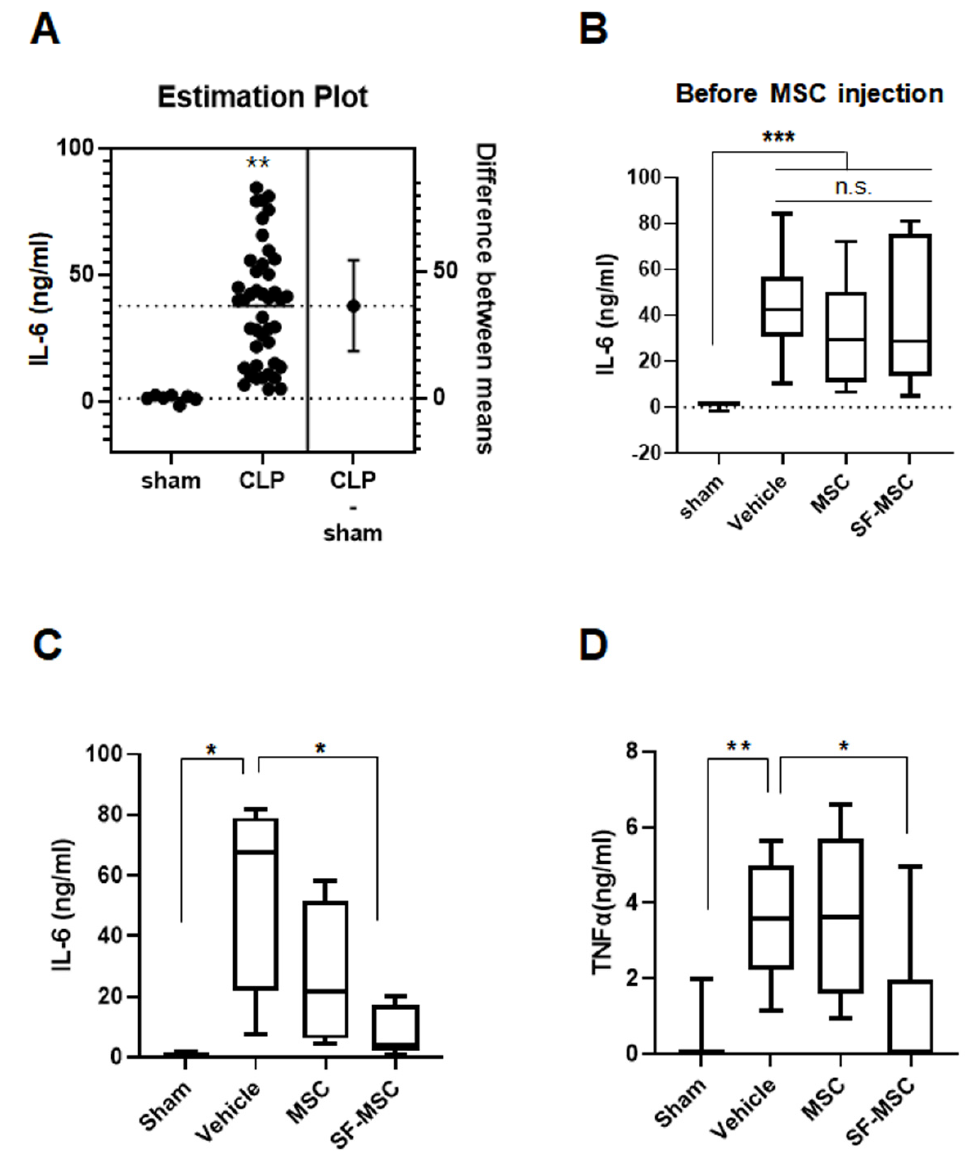
Figure 3. Primed MSCs on the SF nanofibers suppress the level of inflammatory cytokines in septic mice. ( A ) Plasma IL-6 levels were elevated in the CLP mice ( n = 7 animals in the sham group vs. n = 43 animals in the CLP group, unpaired t -test, p = 0.0006). ( B ) IL-6 levels did not differ between the groups before the administration of MSCs (1.28 ng/mL in sham, 43.72 ng/mL in CLP group before injecting vehicle, 32.65 ng/mL in CLP group before injecting primed MSCs on the control surface, 37.77 ng/mL in CLP group before injecting primed MSCs on the SF nanofibers, one-way ANOVA, *** p < 0.001). ( C ) IL-6 levels were significantly reduced in the septic mouse group injected with primed MSCs on the SF nanofibers at 24 h (0.557 ng/mL in sham, 34.50 ng/mL in CLP group, 16.14 ng/mL in CLP with primed MSCs on the control surface, 6.458 ng/mL in CLP with primed MSCs on the SF nanofibers, one-way ANOVA, and * p < 0.05). ( D ) TNF- α levels were highly enhanced in the CLP mice, while effectively attenuated by primed MSCs on the SF nanofibers (0.2843 ng/mL in sham, 3.501 ng/mL in CLP group, 3.5412 ng/mL in the CLP with primed MSCs on the control surface, 1.006 ng/mL in the CLP with primed MSCs on the SF nanofibers, one-way ANOVA, * p < 0.05, and ** p < 0.01). Abbreviation: MSC, primed MSCs on the control surface; SF_MSC, primed MSCs on the SF nanofibers; n.s., not